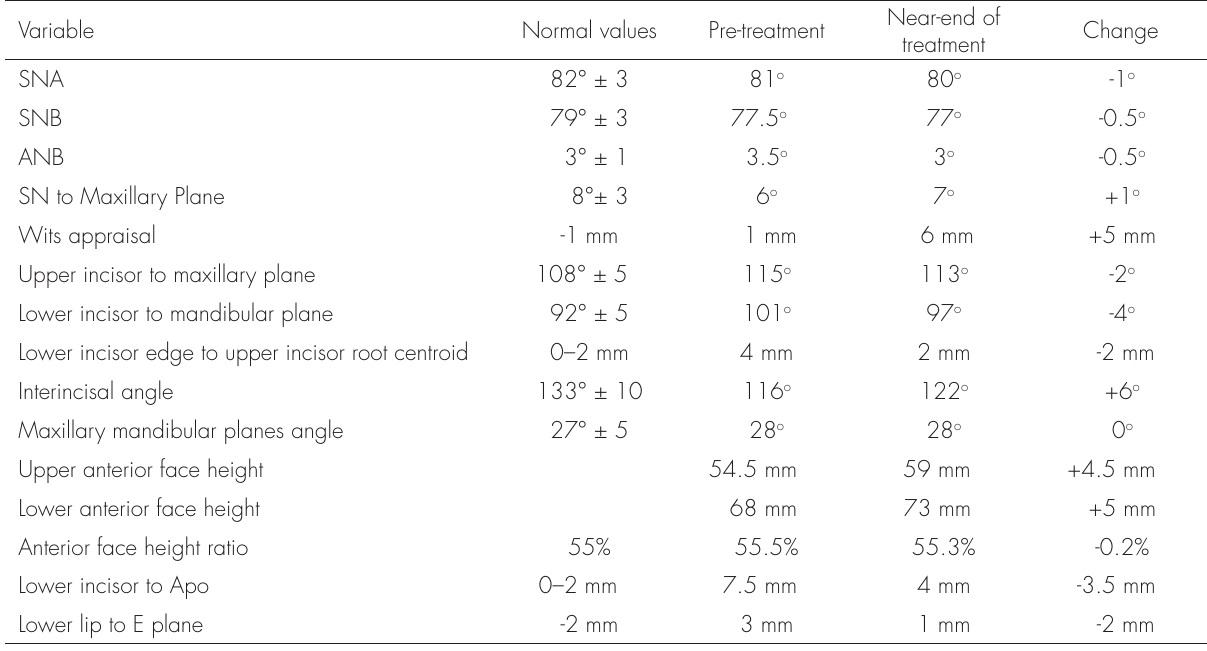
Table I. Pre-treatment and final cephalometric